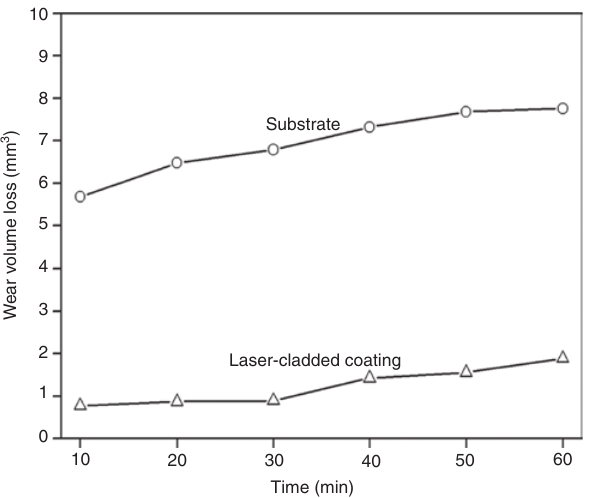
Al-B C-YPSZ-Al 3 4